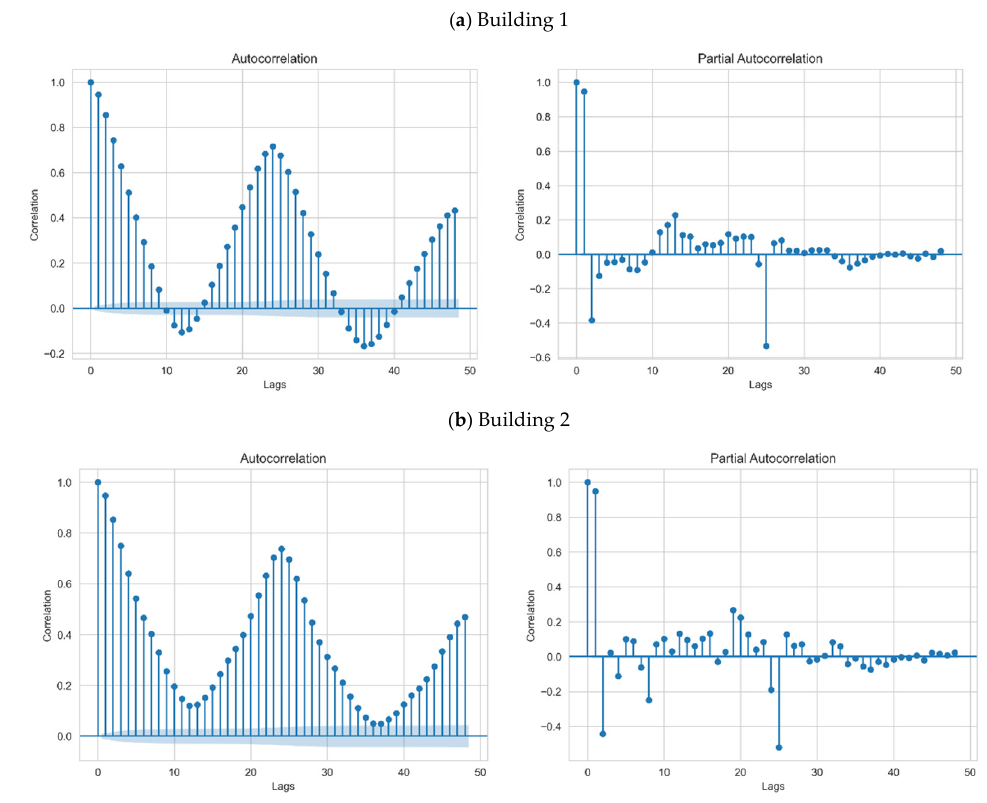
Figure 3. ( a ) ACF and PACF graphs for the time series of building 1; ( b ) ACF and PACF graphs for the time series of building 2.